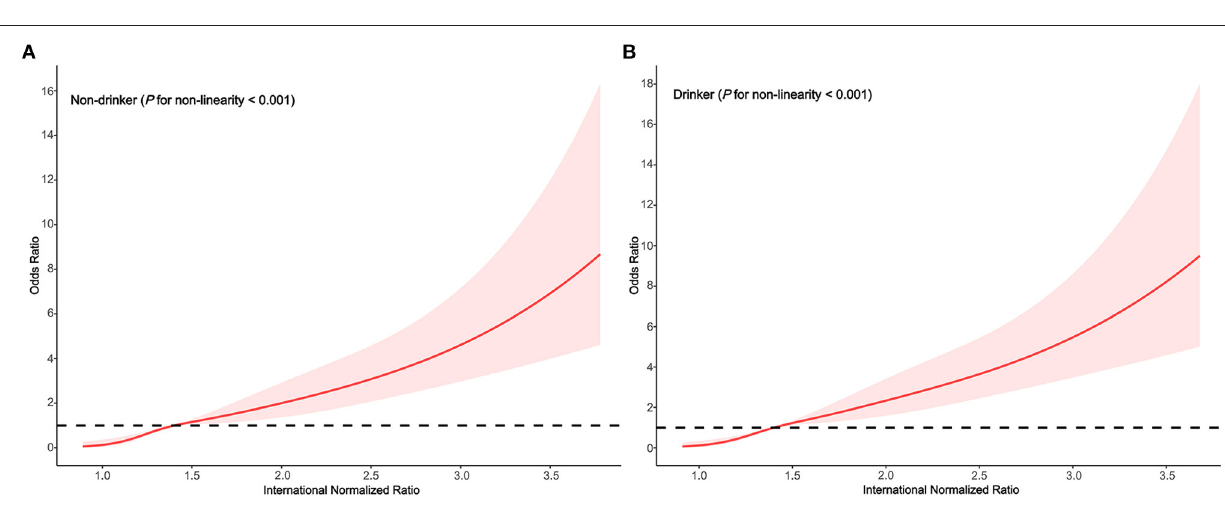
FIGURE 5 | Association between the INR and HE risk based on restricted cubic spline model stratified by drinking status (A) no; (B)